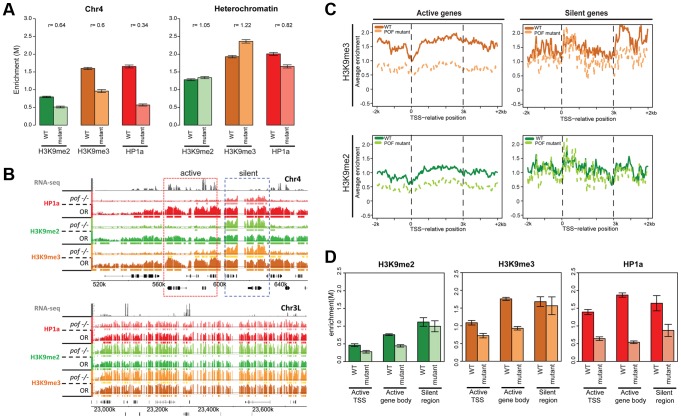
Lack of POF leads to large-scale changes in HP1a and H3K9me2/3 and demonstrates that HP1a on chromosome 4 consists of POF-dependent and -independent pools.A. Mutations in POF alter H3K9me2, H3K9me3 and HP1a enrichment on chromosome 4. Enrichment levels (M-values) are shown for H3K9me2, H3K9me3, and HP1a on chromosome 4 (left) and in pericentric heterochromatin (right) in wildtype (dark color) and pofD119 homozygous mutant (light color) third instar larvae. Error bars: Standard error of the mean (SEM). B. Browser shots illustrating the loss of HP1a on chromosome 4 (top) in pofD119 homozygous mutant third instar larvae and the retention of high levels of HP1a in pericentric heterochromatin (bottom panel). The M-value scale (Y-axis) is identical for wildtype and mutant but differs between marks (0–3 for H3K9me2 and H3K9me3; 0–4 for HP1a). C. Metagene plots showing H3K9me3 and H3K9me2 levels are reduced mainly over active genes on chromosome 4 in the mutant. Genes on chromosome 4 were divided into transcriptionally active (left column) and transcriptionally silent (right) based on RNA-seq data. D. The changes in H3K9me2, H3K9me3, and HP1a enrichment induced by the pof mutation correlate with gene features on chromosome 4. Changes in H3K9me2/me3 and HP1a enrichment (Y-axis: smoothed M-values) are examined separately for TSSs of actively transcribed genes, gene bodies of active genes, and silent regions on chromosome 4. Error bars: SEM.